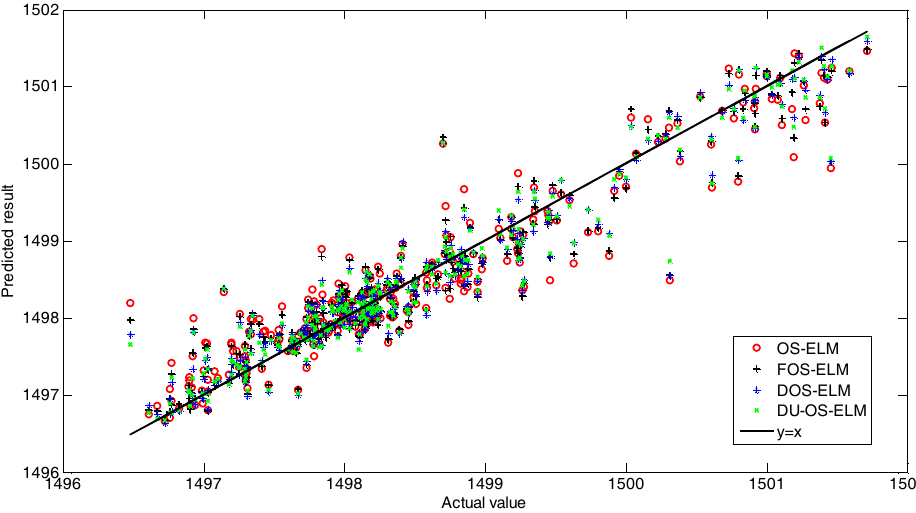
Figure A5. The correlation between the predicted values and actual values.